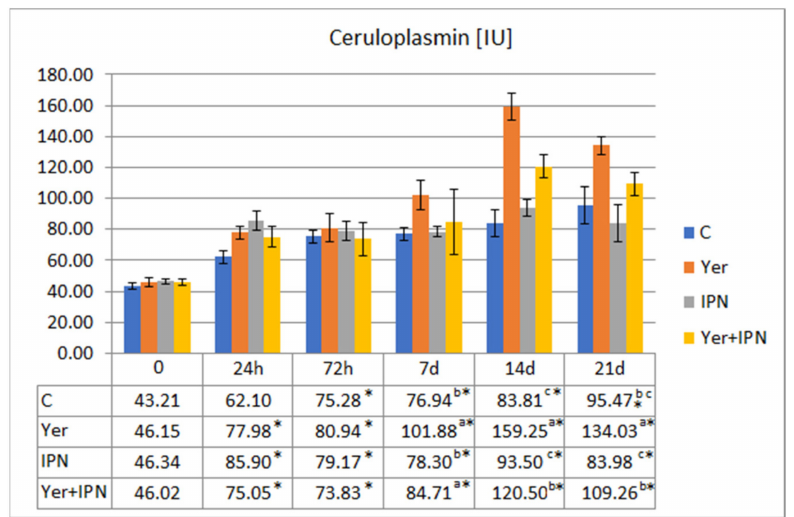
Figure 8. Mean values and standard deviation of ceruloplasmin activity over the course of the first experimental infection. *—statistically significant differences compared to the day 0 values within a given group ( p ≤ 0.05); a, b, c —statistically significant differences between the groups on a given sampling day ( p ≤